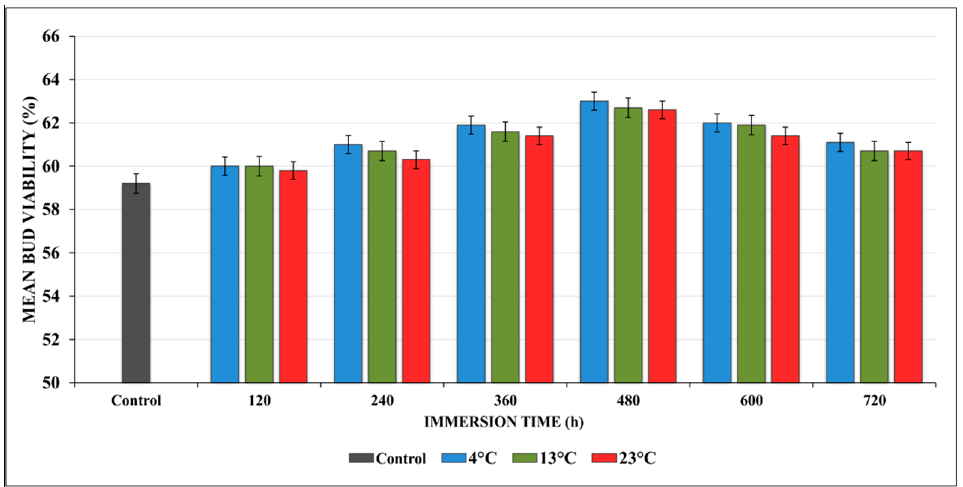
Figure 2. Mean bud viability (MBV) (means ± S.E.) following sea water immersion. Control